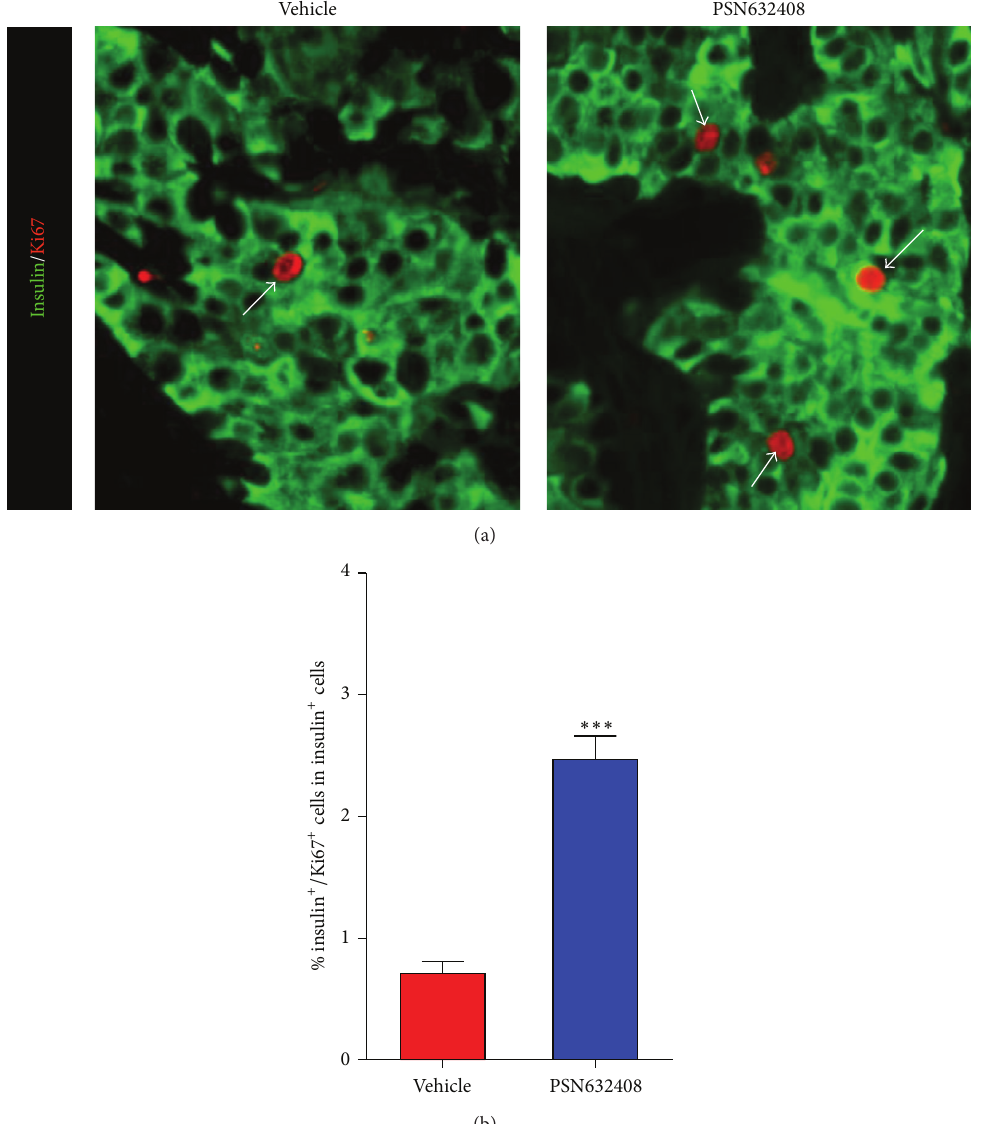
Figure 5: (a) Immunofluorescent staining for insulin (green color) and Ki67 (red color) in human islet grafts from PSN632408- and vehicle- treated mice with normoglycemia at 4 weeks after transplantation. White arrows show insulin/Ki67 copositive cells in human islet grafts. (b) Percentage of insulin/Ki67 copositive cells among total insulin positive cells in human islet grafts. The average percent of insulin/Ki67 copositive cells among total insulin positive cells was significantly higher in PSN632408-treated mice ( 𝑛 = 9 ) compared with vehicle-treated mice ( 𝑛 = 4 ) ( ∗∗∗ 𝑃 < 0.001